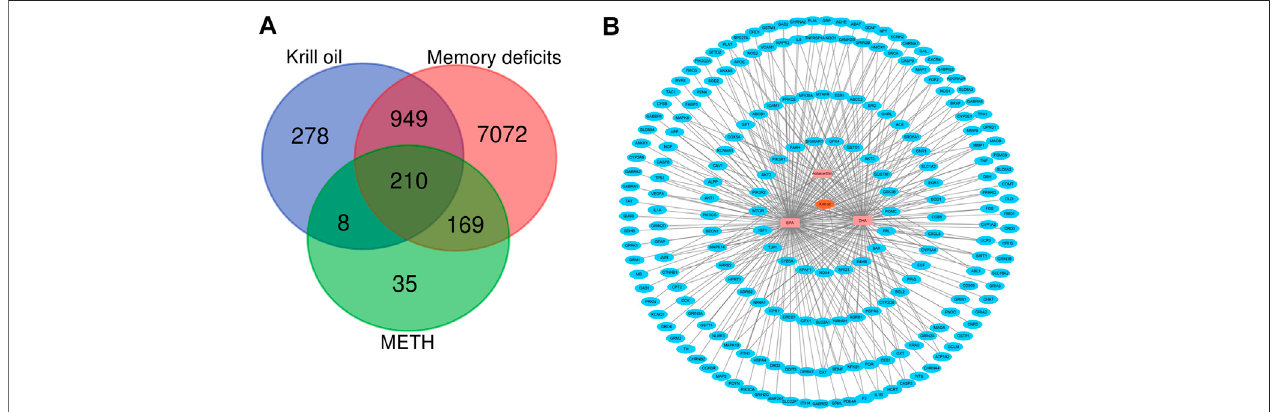
FIGURE 3 | Compound – target network for krill oil on METH-induced memory de fi cits. (A) Venn plot for the possible targets of main compounds of krill oil and related genes of METH and memory de fi cits. (B) Network of active compounds and the possible targets for krill oil on METH-induced memory de fi cits. The orange polygonrepresentedkrilloil.Thepinksquaresrepresentedactivecompoundsofkrilloilandthebluecirclerepresentedpotentialproteintargets.Theedgesrepresentthe interactions between them.